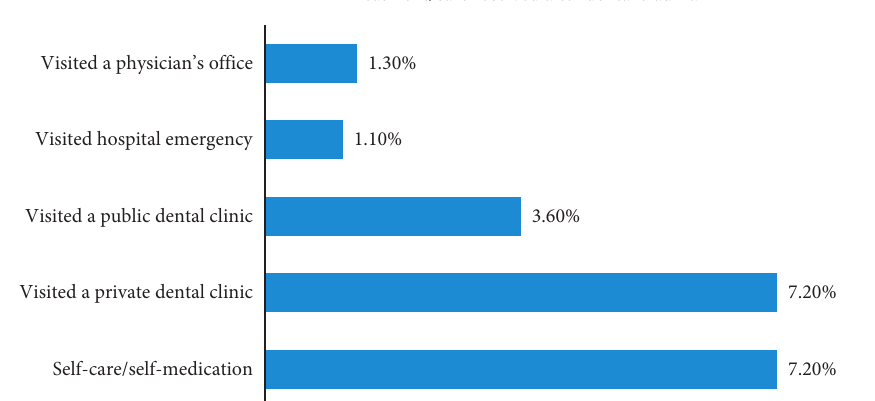
Figure 2: Distribution of participants’ responses about dental treatment/care received after trauma.